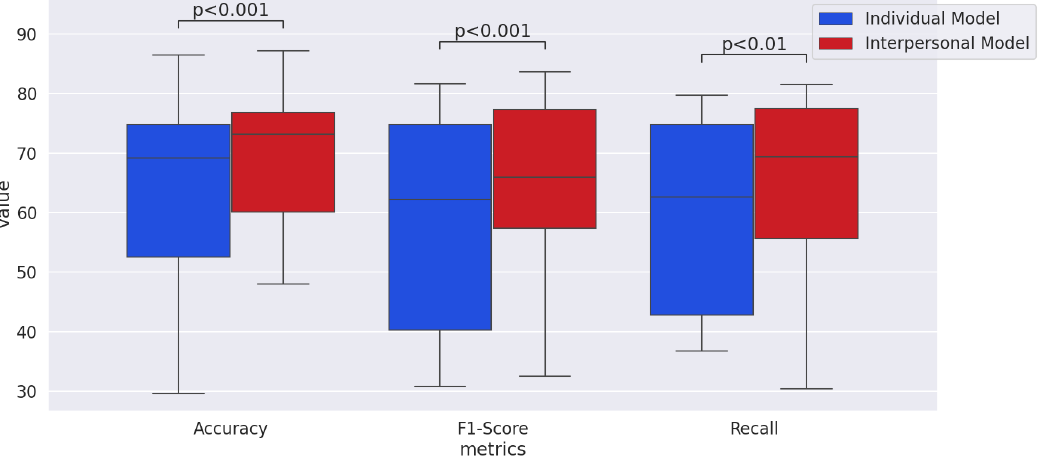
Figure 8. Comparison of the performance metrics between the individual and interpersonal models in the main